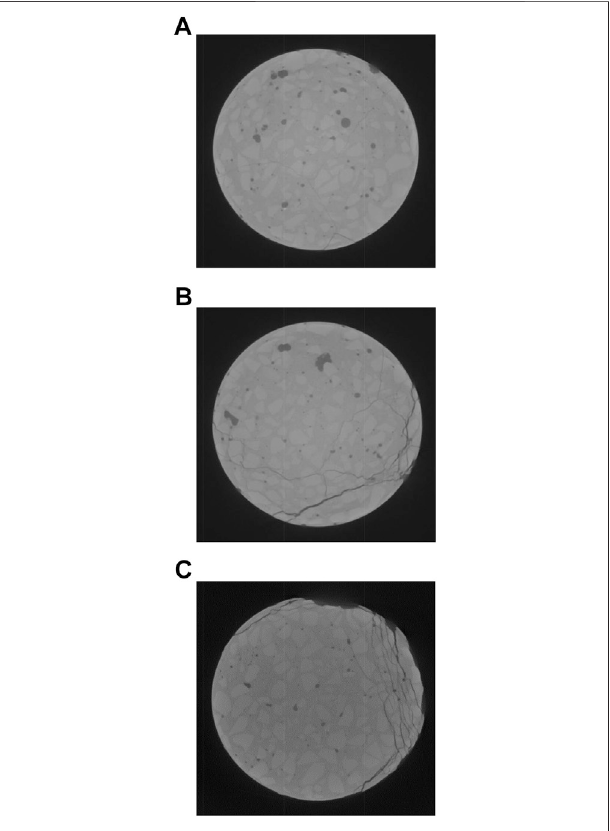
FIGURE 11 | CT images of cracking process in FRCC under cyclic compressive loading: (A) 0 cycles, (B) 20,000 cycles, and (C) 2,000,000 cycles (Mínguez et al.,